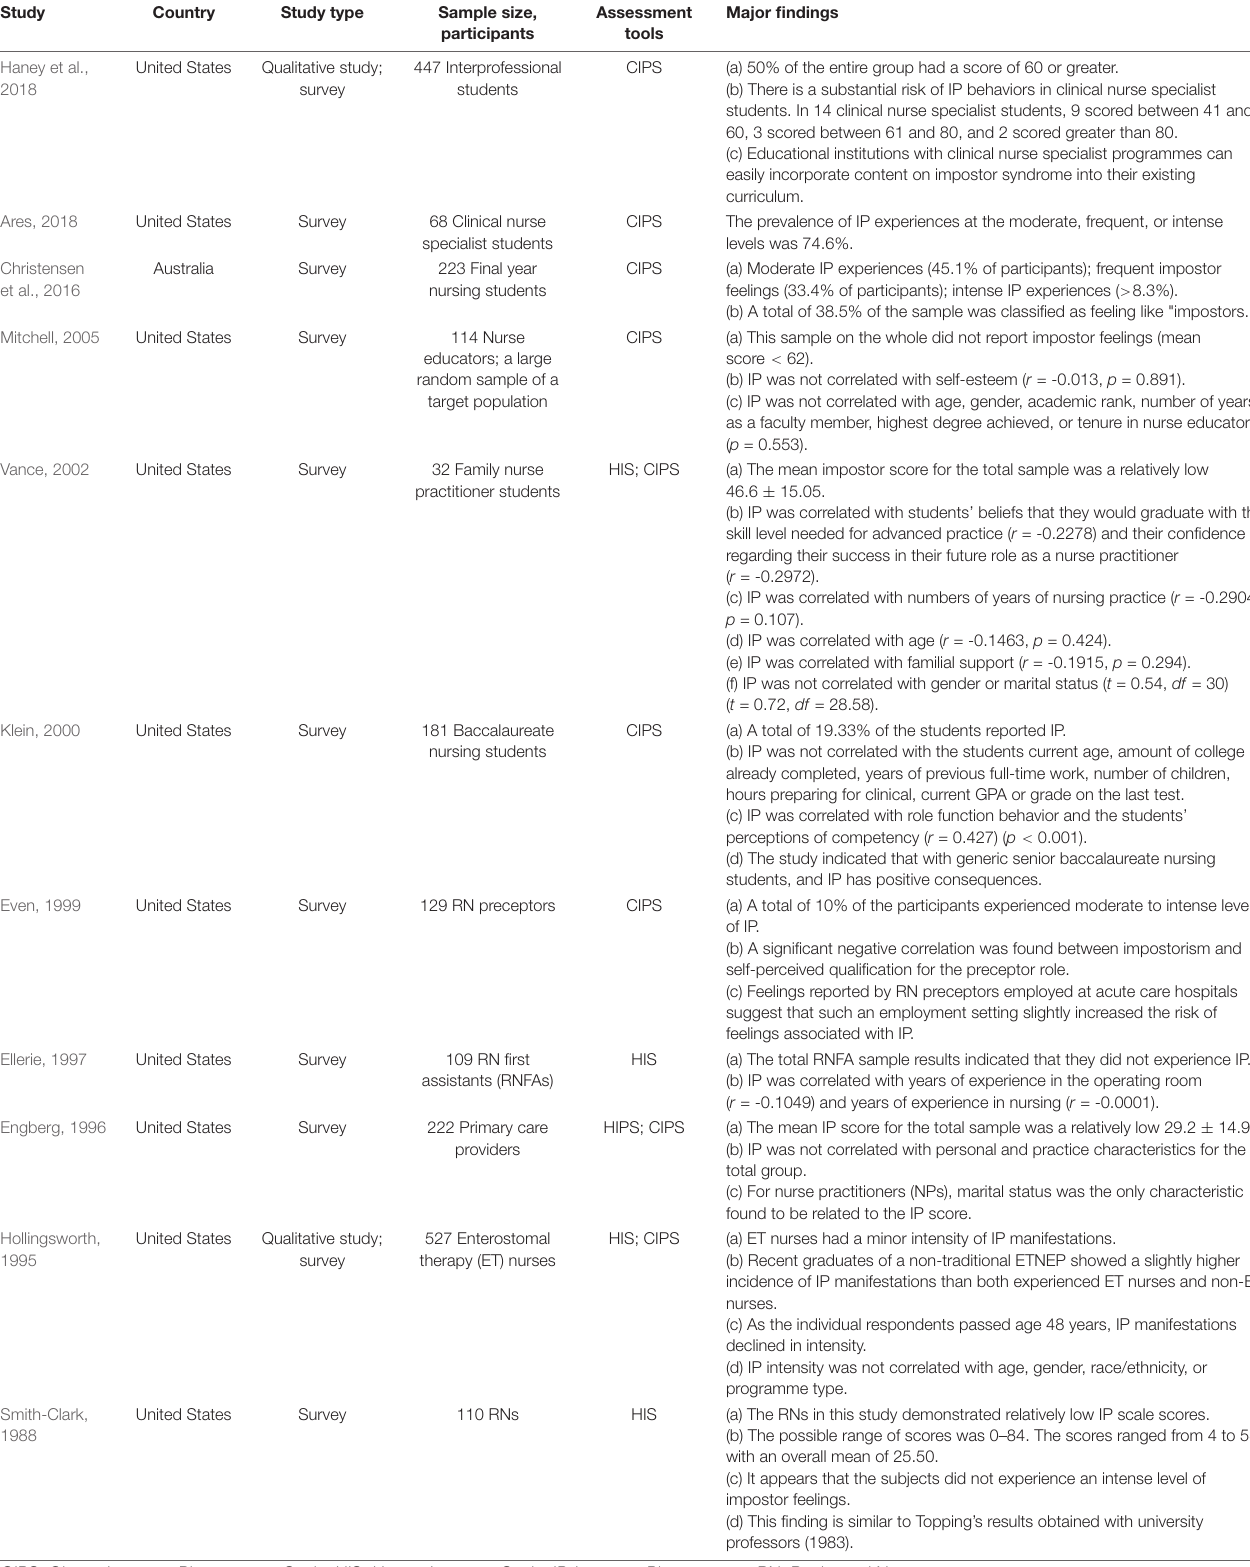
TABLE 1 | Basic information of the included